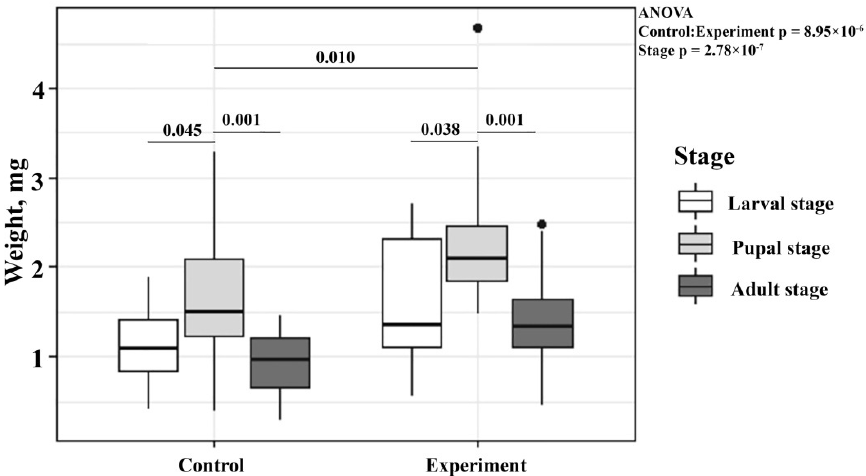
Figure 4. Individual body weight of mosquitoes at different life stages in control and experimental conditions. Each box includes three horizontal lines, which denote 25%, 50% (median), and 75% of the data (from 25% to 75% of the data are enclosed in a rectangle); the upper whisker extends from the first quartile to the maximum value no further than 1.5 × IQR (where IQR is the interquartile range); lower from the third quartile to the smallest value, no further than 1.5 × IQR of data; ( ⚫ ), values beyond ± 1.5 × IQR.